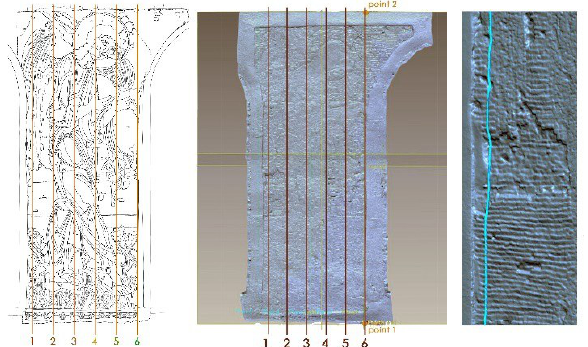
Figure 12. Morphology analysis of the wall mosaic Angel with detail of the